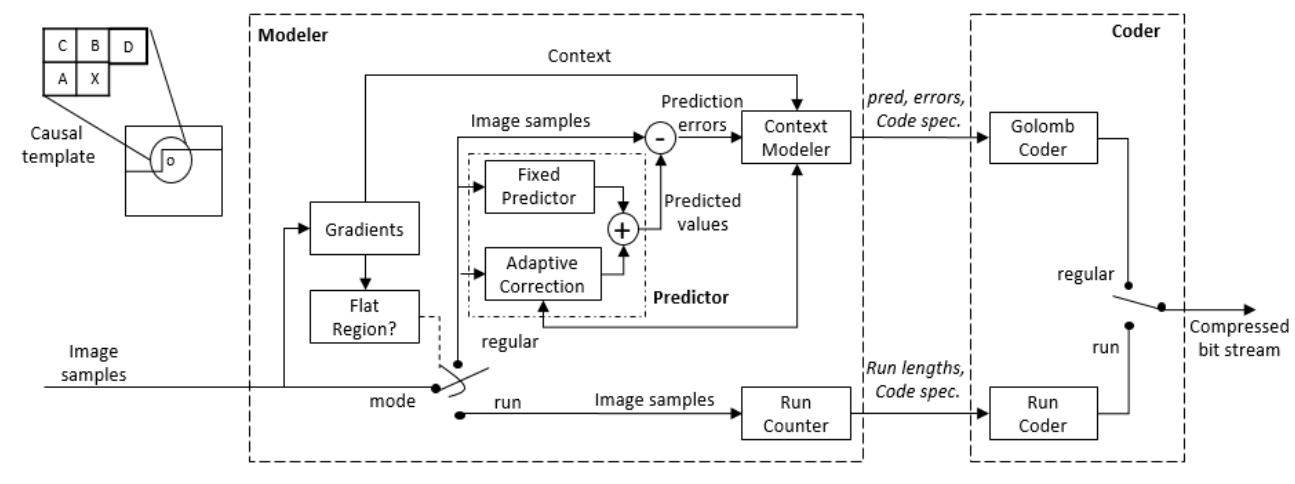
Figure 9. Block diagram for the JPEG-LS encoder